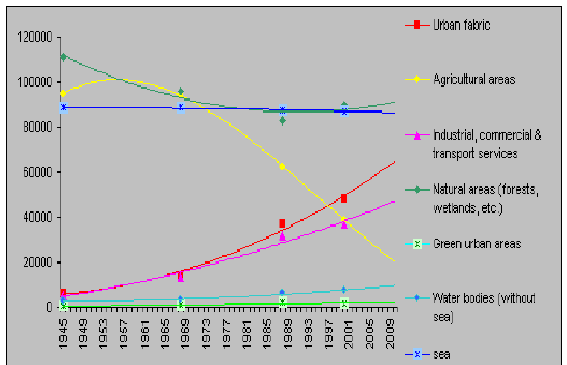
Figure 5: Length of the transportation network in km on the Asiatic and European side of